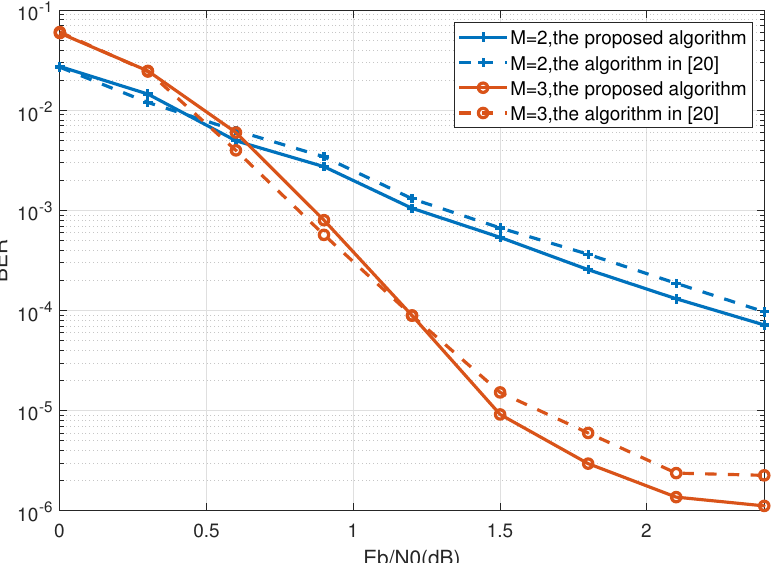
Figure 6. BER performance of turbo-Hadamard codes with different numbers of component